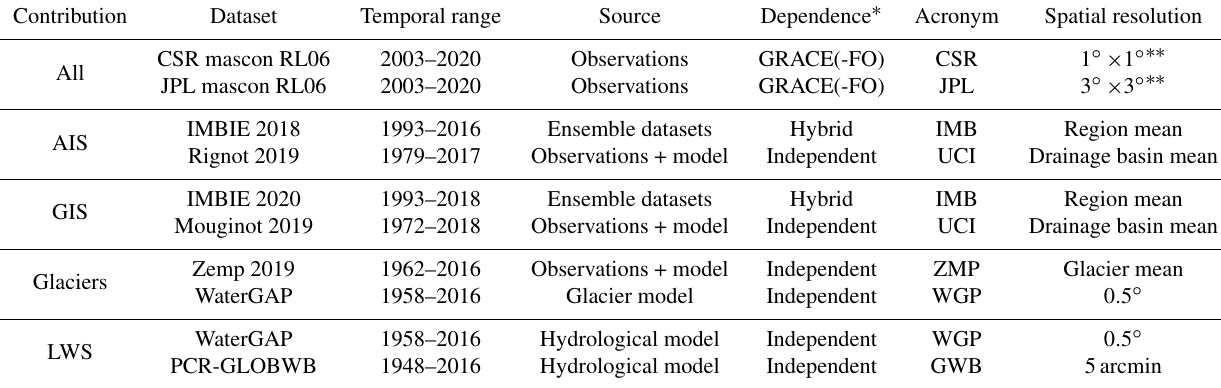
Table 1. Overview of datasets used in this paper.